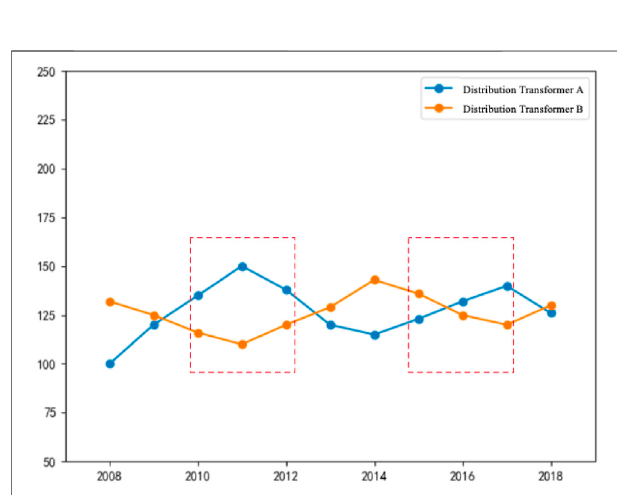
FIGURE 3 | Power load images.